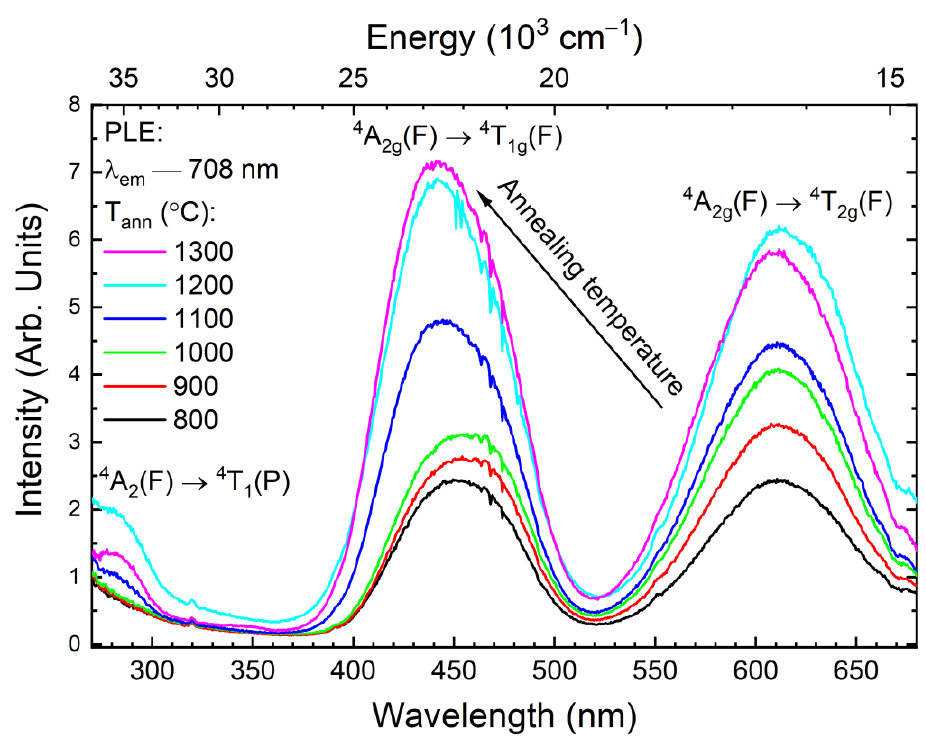
Figure 4. Photoluminescence excitation spectra of the YAGG doped with 1% Cr 3+ powders as a function of annealing temperature.